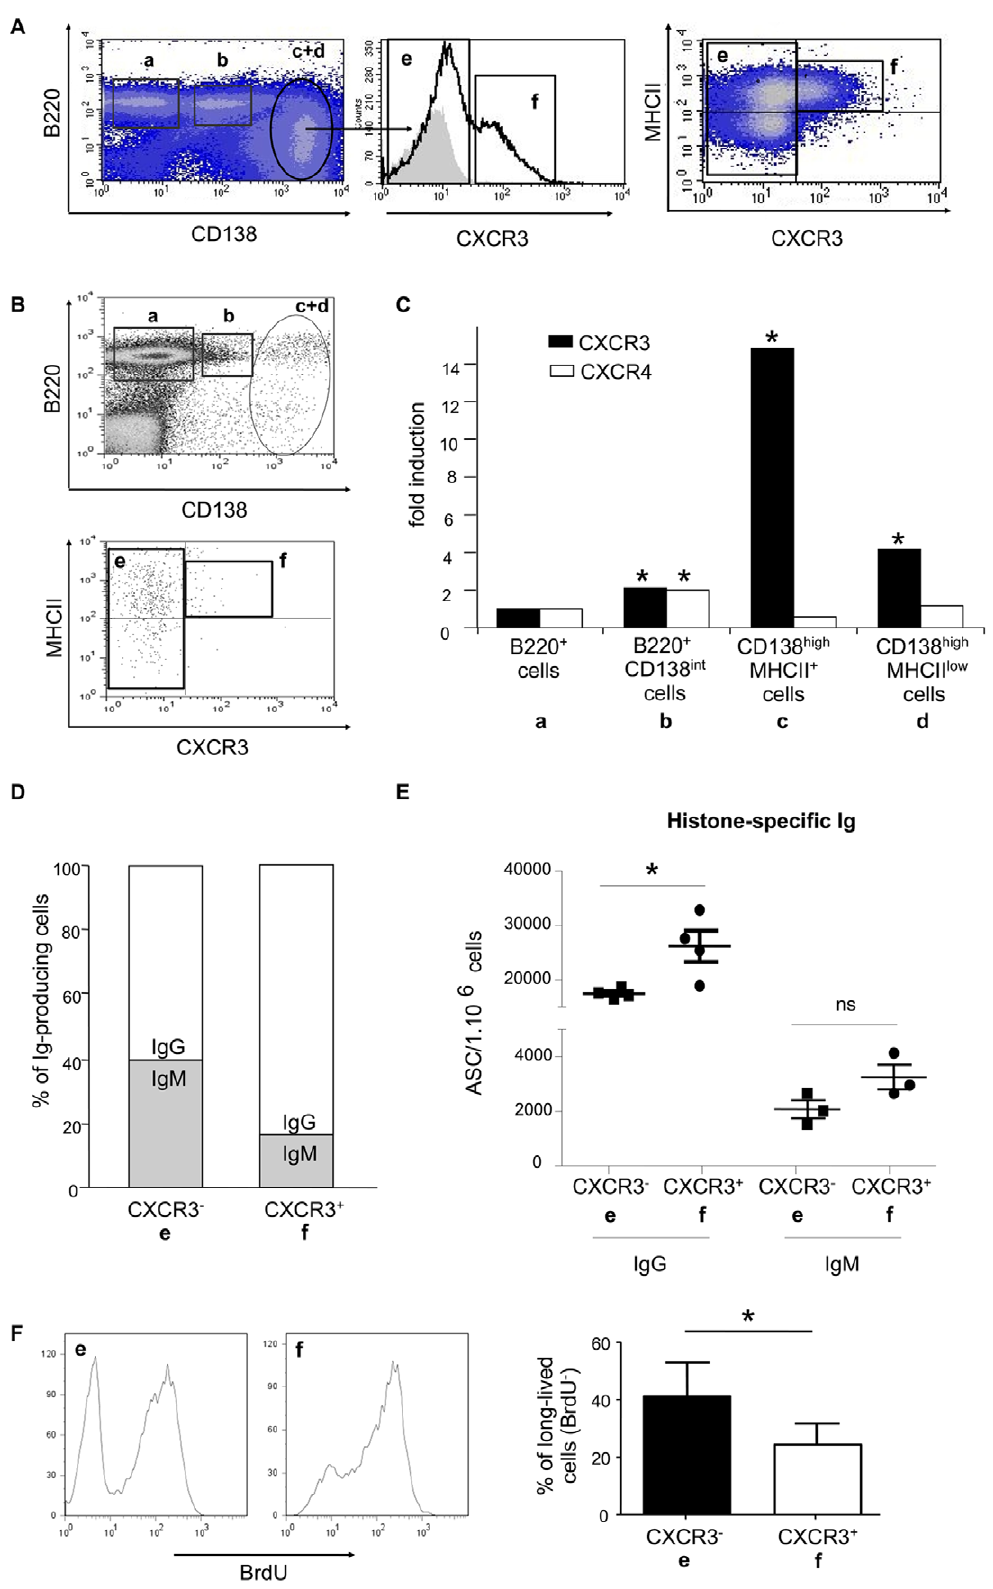
Figure 4. CD138 high MHCII + cells preferentially express CXCR3, produce IgG autoantibodies and encompass some long-lived cells. A) CD138-enriched spleen cells of diseased NZB/W mice were analyzed for CXCR3 expression by flow cytometry. Cells were co-stained with anti-B220, anti-CD138, anti-MHCII and anti-CXCR3 Ab. Among CD138 high cells, two subsets can be defined: one which does not express CXCR3 (e) and one